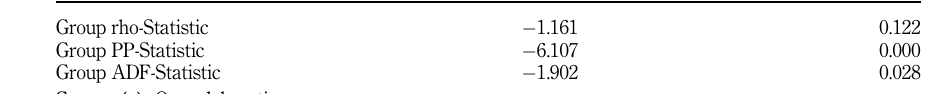
cointegration tests